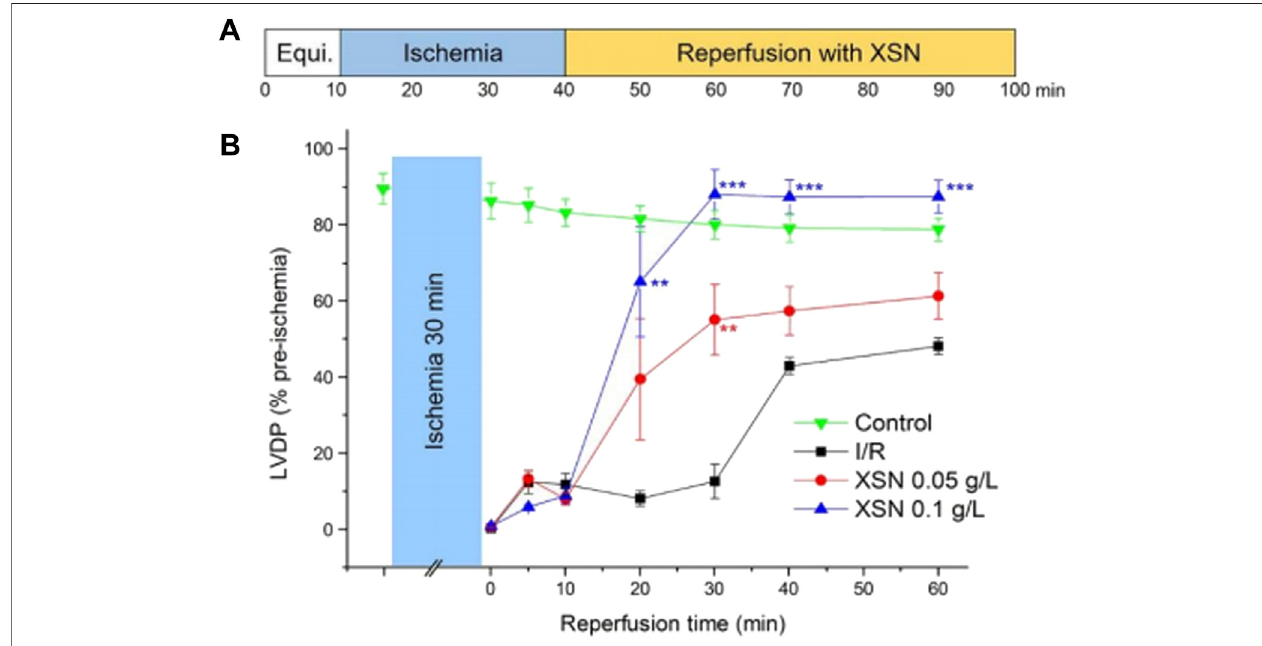
FIGURE 2 | Protective effect of XSN on ischemia/reperfusion-induced injury of the heart. (A) Protocol of contractile function of an I/R perfused rat heart; (B) % rate of LVDP of rat hearts after XSN treatment versus control (Wang et al., 2018).